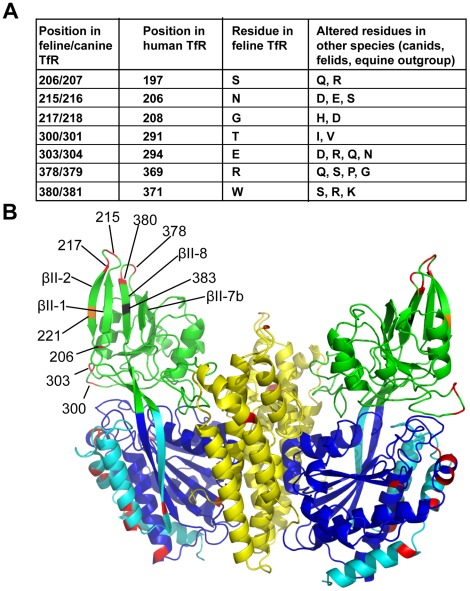
The positions of the positively selected residues in the TfR structure.
A) A listing of the TfR residues in the apical domain under positive selection as revealed by PAML analysis, showing the positions in the different TfRs, and the alternative residues found. B) Residues found to be under positive selection mapped in red onto the crystal structure of the human TfR ectodomain, and those in the apical domain were labeled with the corresponding feline TfR coordinates [28]. The 3 domains of the ectodomain are shown in green (apical domain), blue (protease-like domain), and yellow (helical domain). Strands of the apical domain β-sheet which influence virus binding are labeled. Some residues under positive selection are close to the host-range determinant (feline 383/canine 384) (shown in black) and the leucine at residue 221 (shown in orange) which can be mutated to block capsid attachment, and to discriminate between FPV and CPV in vitro
[15], [16].